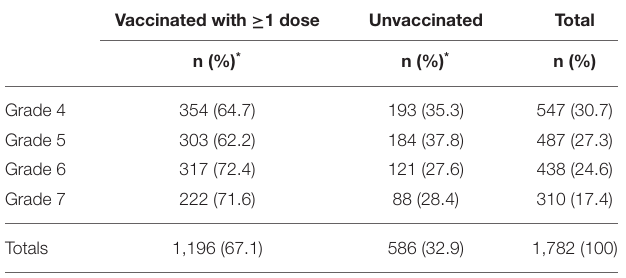
TABLE 2 | Frequency distribution of girls’ grades stratified by HPV vaccination status ( n = 1,782). Vaccinated with ≥ 1 dose